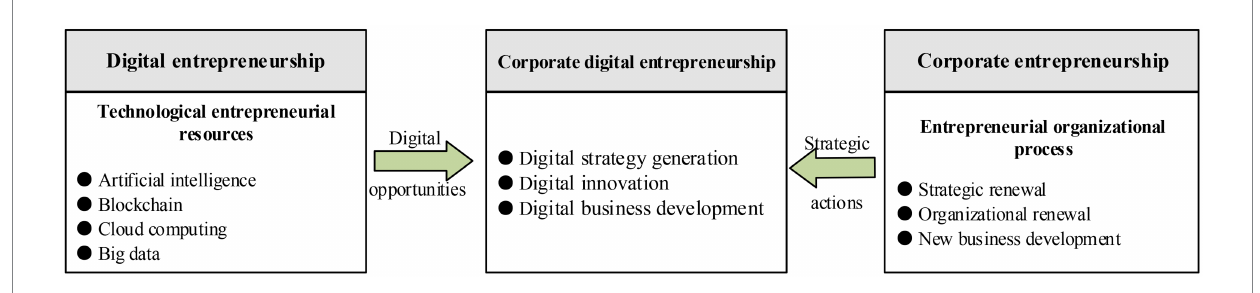
FIGURE 1 The framework of CDE. This figure is drawn by the authors based on Li